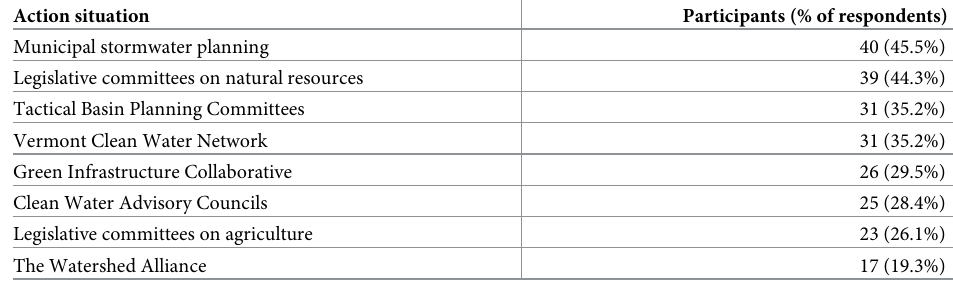
Table 2. The number of respondents that participate in the water quality action situations in the Lake Champlain Basin. Percent of total respondents participating included in